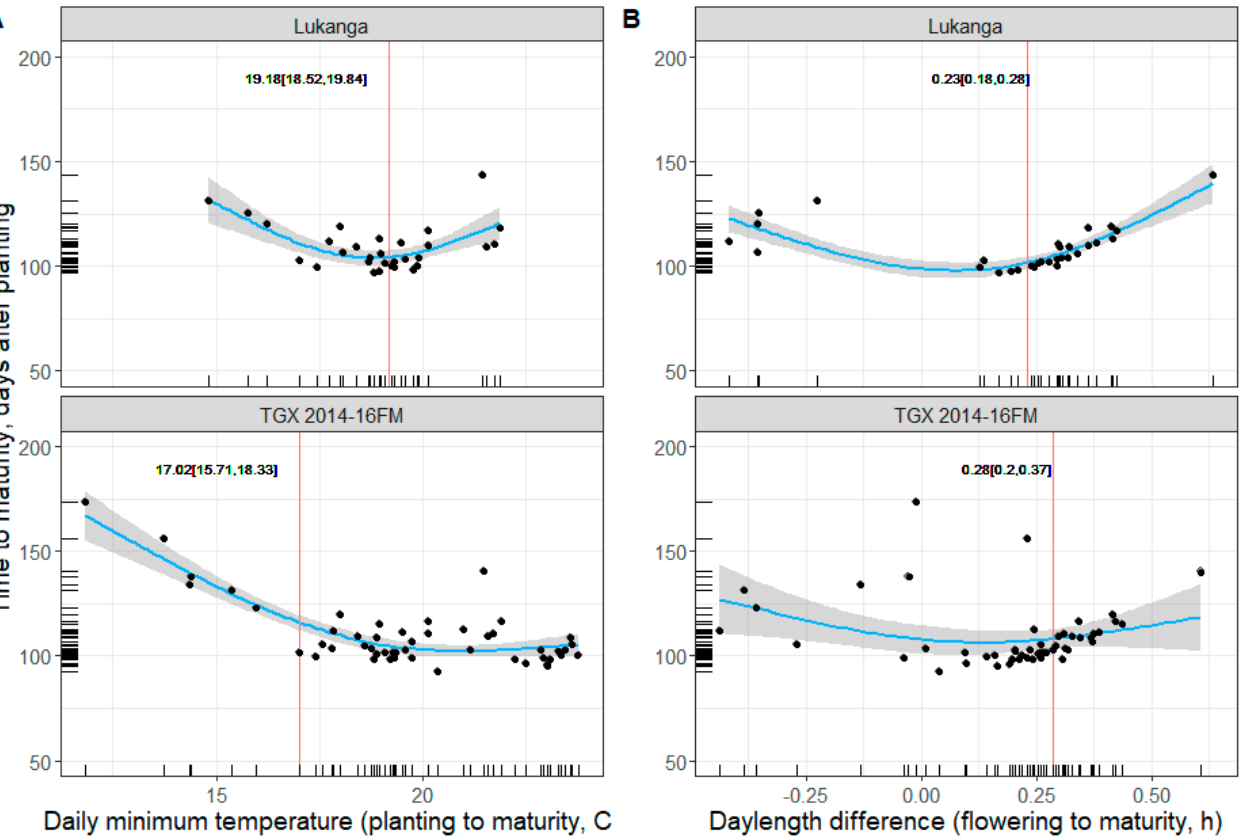
Figure 7. GAM-smoothed response of soybean time to maturity (TTM) to seasonal variables during the growing cycle. Each dot represents a testing site where the given cultivar was evaluated. Red parallel lines indicate a change in the direction of the response, and were approximated through segmented regression (Appendix A).